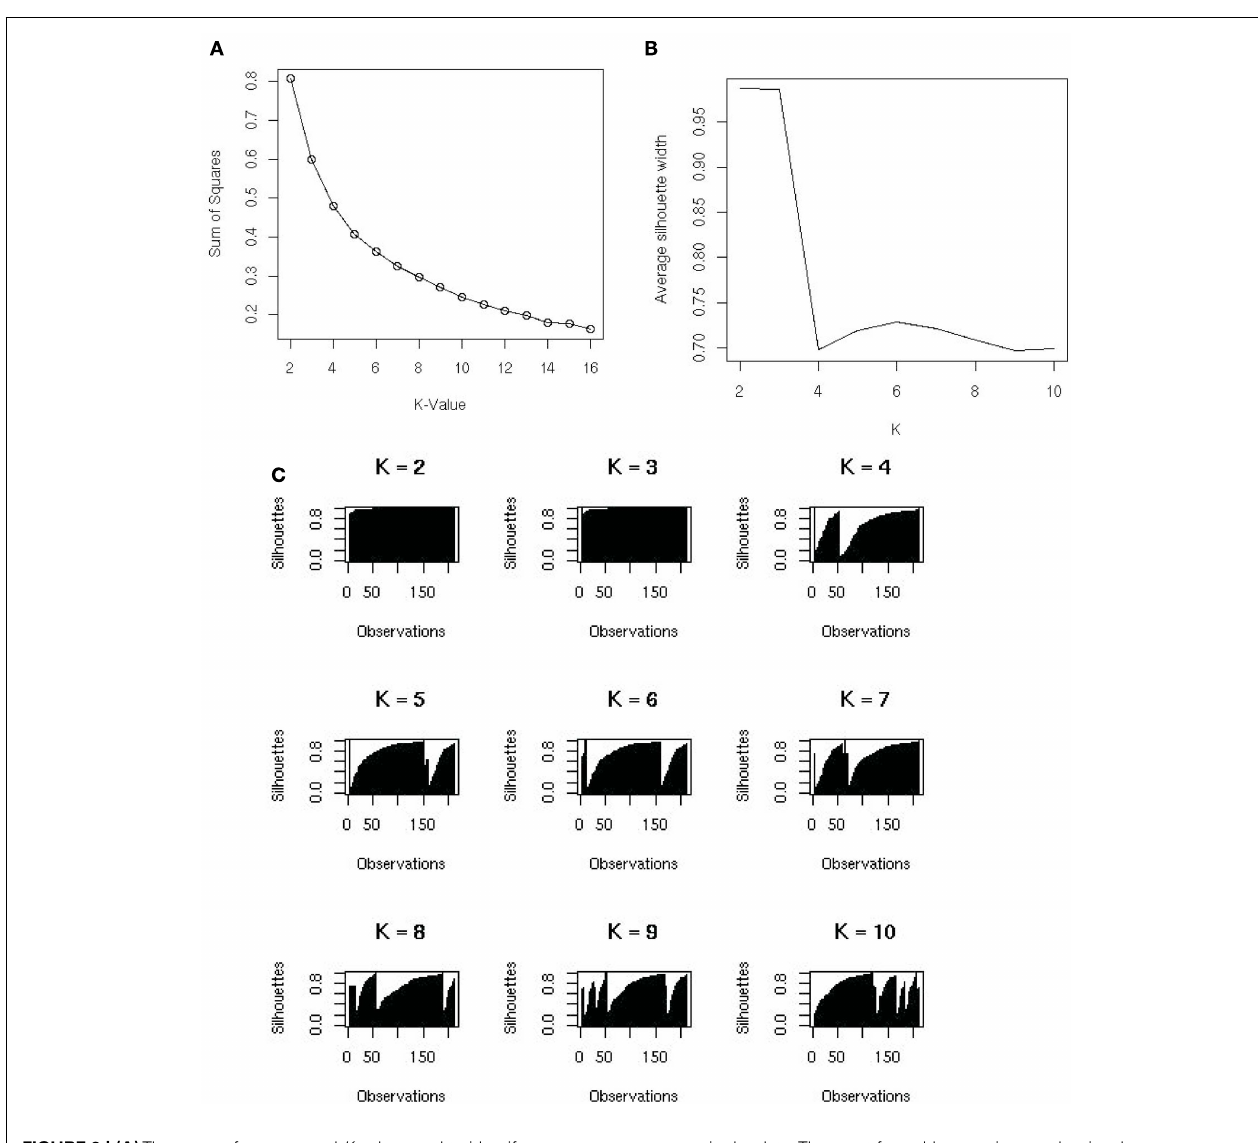
FIGURE 3 | (A) The sums of squares and K -value used to identify the number of groups that the samples should be split into. No clear elbow was evident; therefore silhouette plots were used to examine the data. (B) A silhouette plot showing how it creates metagenomic